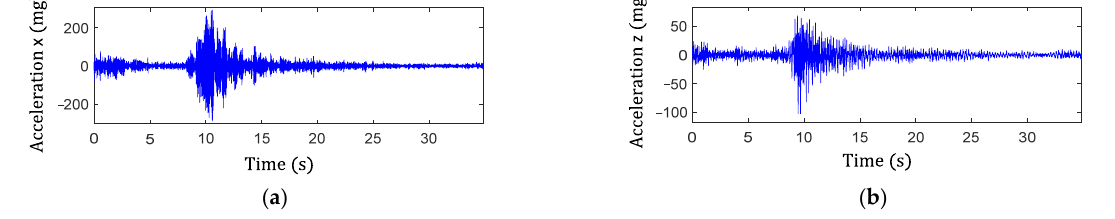
Figure 14. Acceleration measurements containing single impulsive traffic event: ( a ) lateral direction and ( b ) vertical direction.